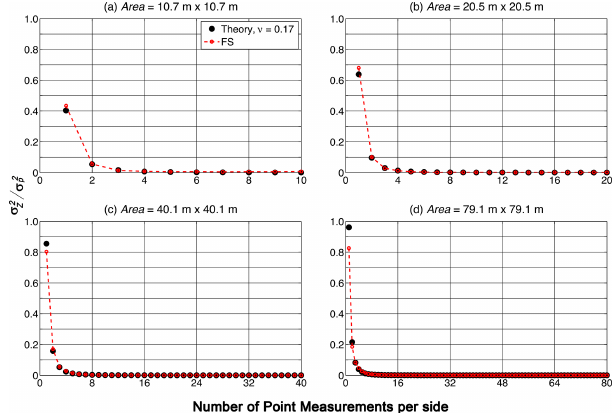
Figure 16. Theoretical normalized squared error ( σ 2 N by N point pattern in Fig. 12b, and for areas of side dimension ( L ) between 10 and 80. The exponential exponent is varied between 0.1 and 5.